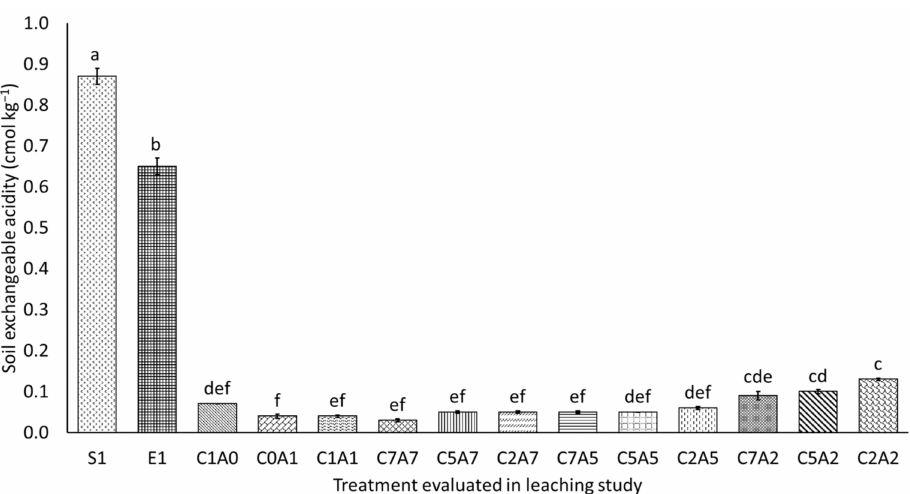
Figure 7. Treatments on soil exchangeable acidity after thirty days of leaching, where S1: soil only; E1: soil with ERP only; C1: 100% charcoal; C0: 0% charcoal; C7: 75% charcoal; C5: 50% charcoal; C2: 25% charcoal; A1: 100% sago bark ash; A0: 0% sago bark ash; A7: 75% sago bark ash; A5: 50% sago bark ash; A2: 25% sago bark ash. Means with different letter(s) indicate significant differences between treatments according to Tukey’s HSD test at p ≤ 0.05, that is, a > b > c. Bars represent the mean values ±